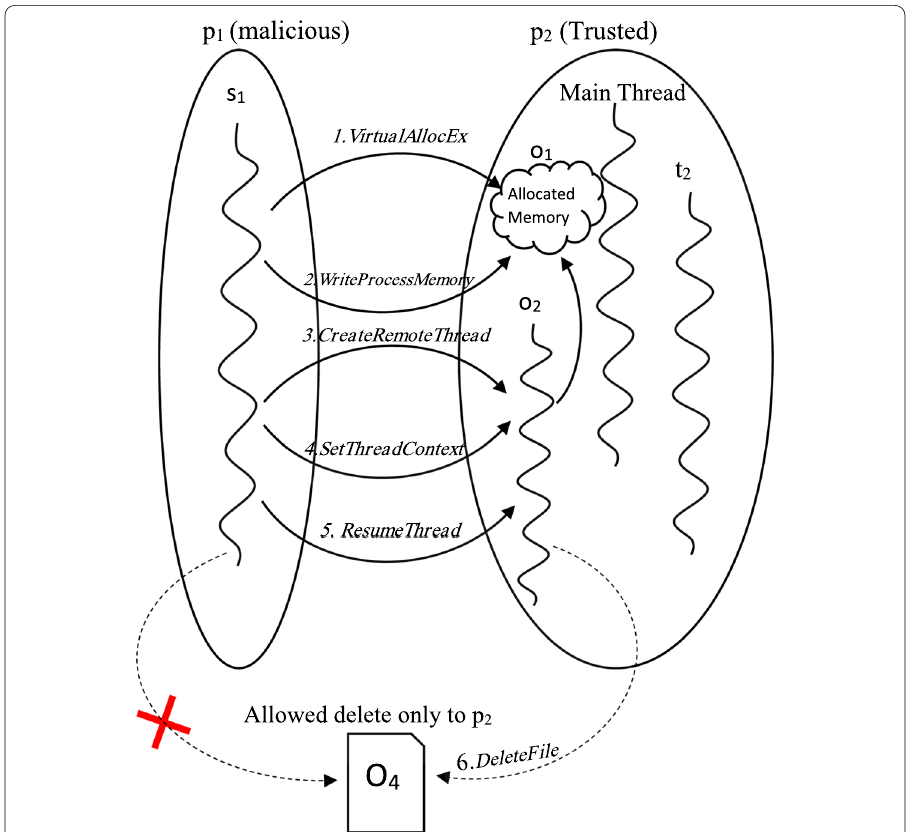
Fig. 12 Implicit file removal through code injection into process p 2 by process p 1 [16]